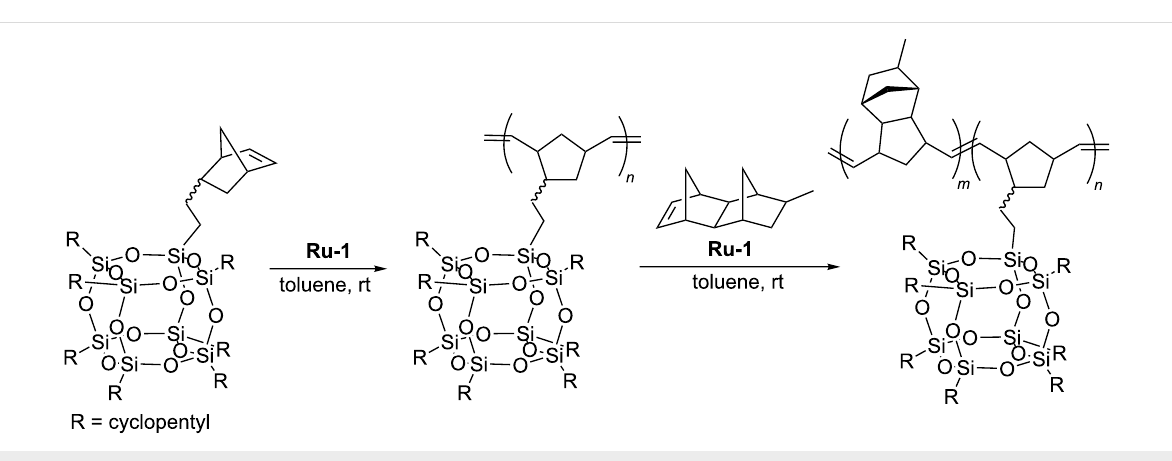
( M n = 17,900–26,300 Da) and narrow molecular weight